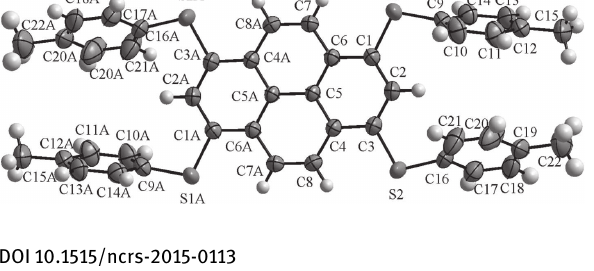
Table 1: Data collection and handling.